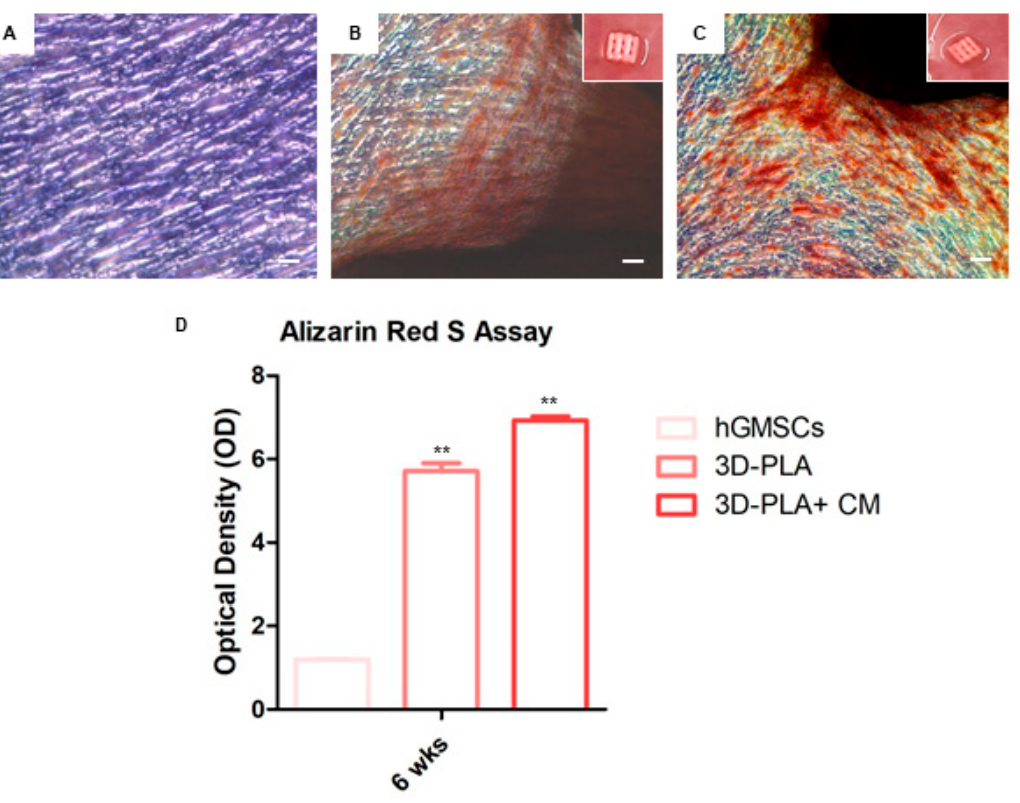
Figure 3. In vitro osteogenic performance. hGMSCs maintained under standard conditions for six weeks and subsequently stained with Alizarin Red S solution. ( A ) hGMSCs used as control culture; ( B ) hGMSCs cultured with poly-(lactide) (3D-PLA) scaffold; ( C ) hGMSCs cultured with 3D-PLA + conditioned medium (CM); ( D ) histograms of alizarin red S staining quantification. Scale bars represent 10 µ m. Graph optical density: ** p < 0.01 was considered statistically significant.